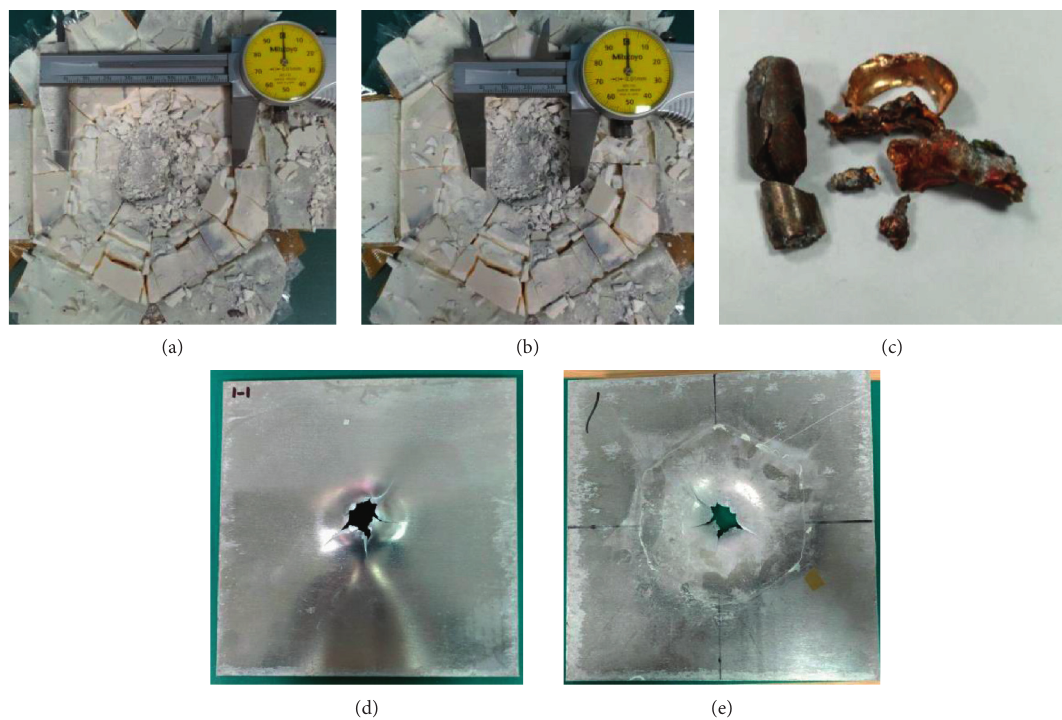
Figure 8: 10% 333 FGM + 4mm Al backplate. (a) The bottom of the ceramic conoid. (b) The top of the ceramic conoid. (c) Residual bullet. (d) The back of the aluminum backplate. (e) The front of the aluminum